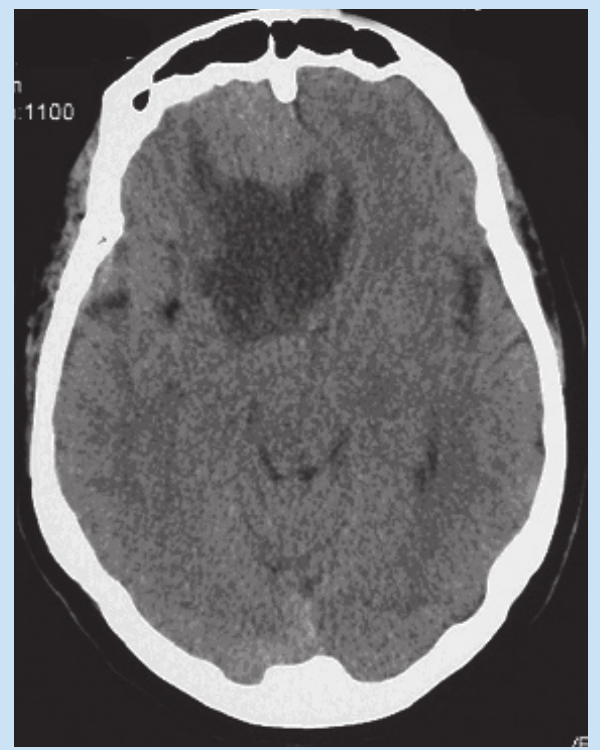
Fig. 1a. Pre-contrast image showing hyperdense right temporal and frontal parasagittal meningiomas.